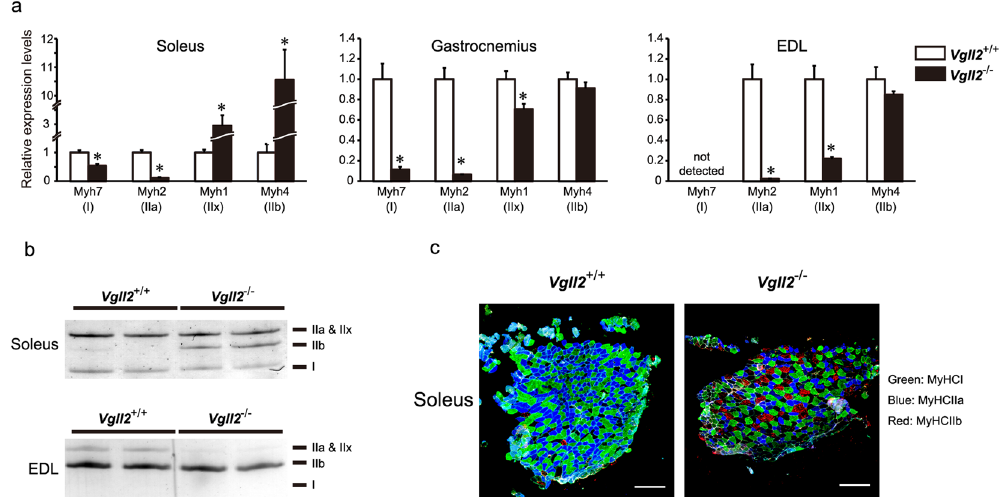
Figure 3. Fiber type composition analysis based on the expression of myosin heavy chain isoforms in adult skeletal muscles. ( a ) Expression levels of genes encoding MyHC isoforms, Myh7 (I), Myh2 (IIa), Myh1 (IIx), and Myh4 (IIb) were measured by qPCR in the soleus, gastrocnemius, and EDL muscles from 12-week-old Vgll2 + / + and Vgll2 − / − mice (n = 6). For comparison, the expression level of these genes in Vgll2 + / + mice was arbitrarily set at 1. Data are presented as mean ± SEM. * P < 0.05 vs. Vgll2 + / + in each muscle. ( b ) High resolution gel electrophoresis for MyHC isoform separation of protein extracts isolated from the soleus and EDL muscles of 12-week-old Vgll2 + / + and Vgll2 − / − mice. Equal amounts (50 ng) of total protein were separated on an 8% acrylamide gel containing glycerol. The gel was then stained with the silver stain method. Uncropped original images are shown in Supplementary information. ( c ) Representative images of immunostained soleus muscles isolated from 12-week-old Vgll2 + / + and Vgll2 − / − mice (n = 3). Scale bar: 200 μ